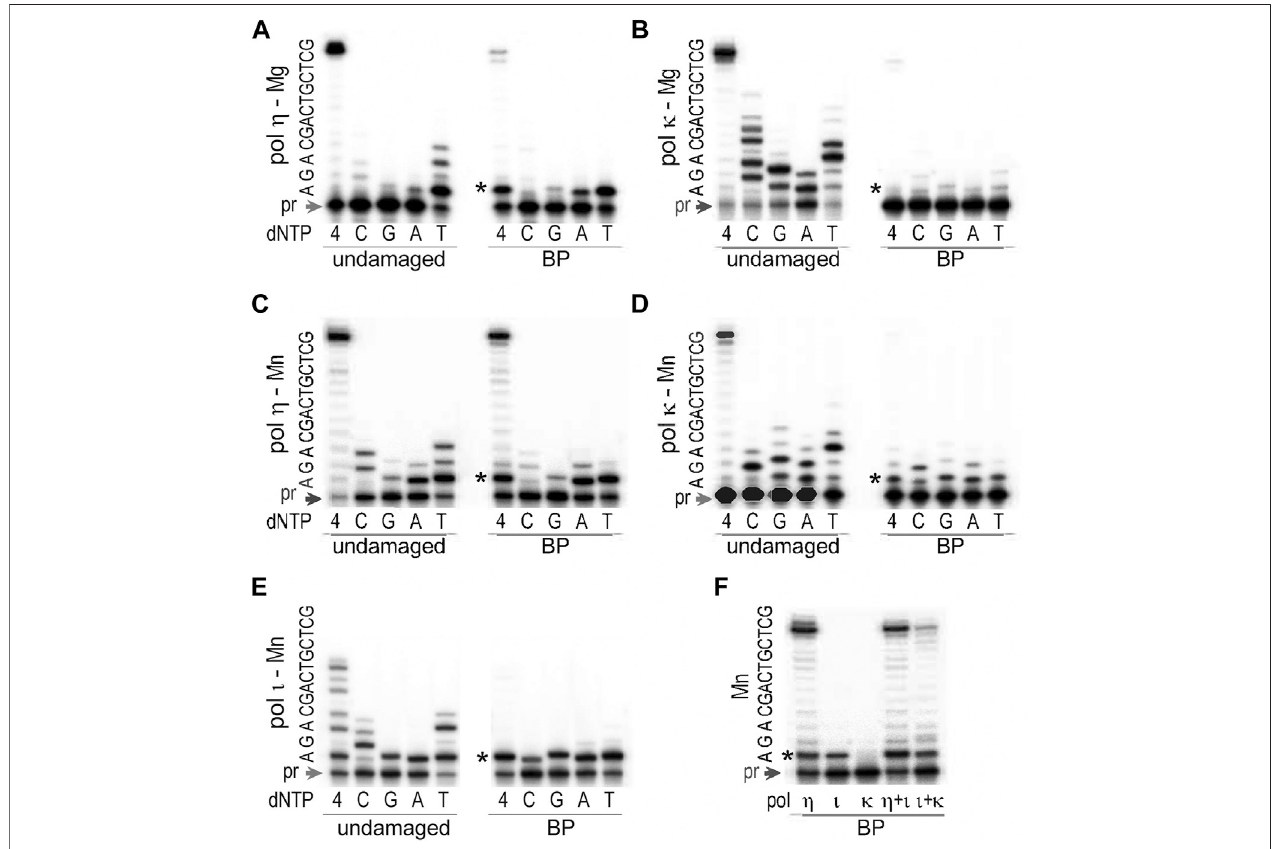
FIGURE 6 | TLS past trans - S -BPDE-dA by T. lanuginosus pols. The ability to bypass BPDE-dA was assayed for (A) pol η in presence of 4 mM Mg 2+ , (B) pol κ in presence of 4 mM Mg 2+ , (C) pol η in presence of 4 mM Mn 2+ , (D) pol κ in presence of 4 mM Mn 2+ , (E) pol ι in presence of 4 mM Mn 2+ , and (F) individual, or mixture of various pols in 4 mM Mn 2+ . The substrate used in these assays was made by annealing of the 32 P labeled primer 5 ′ -CACTGCAGACTCTAAA-3 ′ and either an undamagedor BPDE-containingtemplate 5 ′ -GCTCGTCAGCAG A TTTAGAGTCTGCAGTG-3 ′ ,wheretheunderlined boldAstandsfortheundamaged,or BPDE- modi fi ed dA. Reactions contained 100 μ M each individual nucleotide (dC, dG, dA, dT)or mixture ofall four dNTPs as indicated in the fi gure and were carried outat 37 ° C for 10 min. Concentrations of enzymes were 0.17 pM for pol η , 0.32 pM for pol κ , and 0.15 pM for pol ι . The sequence of the template immediately downstream of the primer (pr) is shown on the left-hand side of each gel pair. The star (*) indicates position of the adduct.